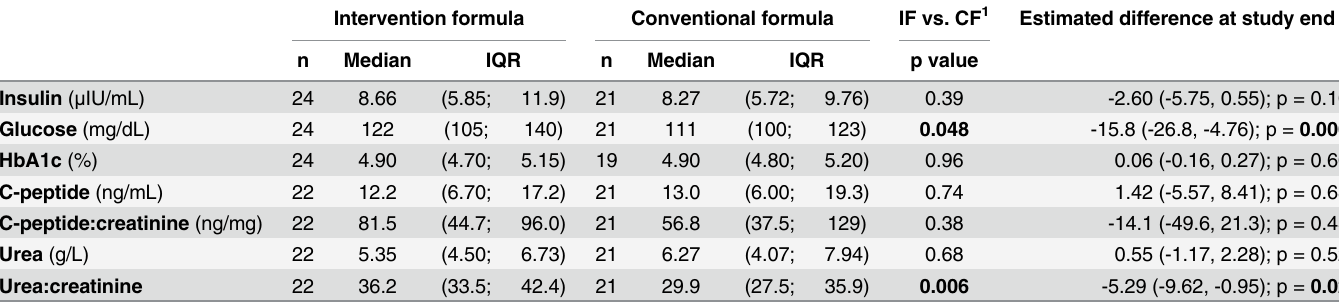
Table 1. Capillary postprandial plasma insulin, blood glucose and HbA1c and urinary c-peptide and urea concentrations at study end (intention- to-treat population). Intervention formula Conventional formula IF vs. CF 1 Estimated difference at study end